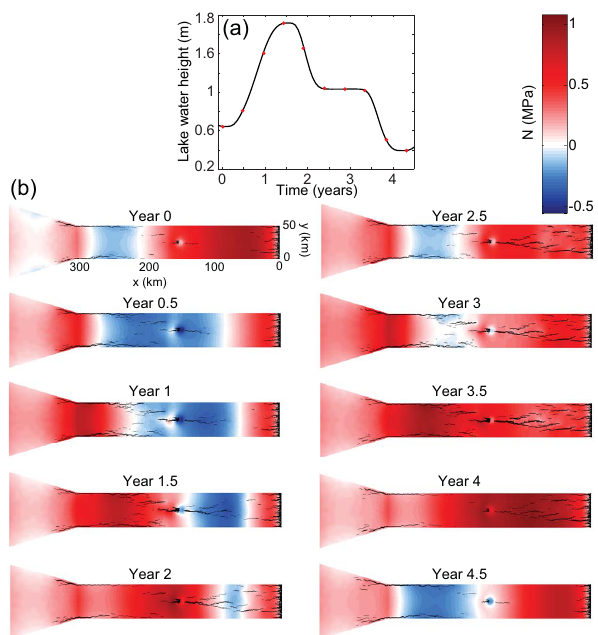
Figure 5. Changes in effective pressure in the ice stream (from years 48 to 52.5) over one lake filling and draining cycle, which occurs over two pressure wave cycles. (a) Lake water level (black curve) with pressure plot timing indicated by the red dots. (b) Pres- sure plots at six month intervals. Black lines indicate channels, with the line thickness illustrating channel size. The overdeepening is located 150km from the